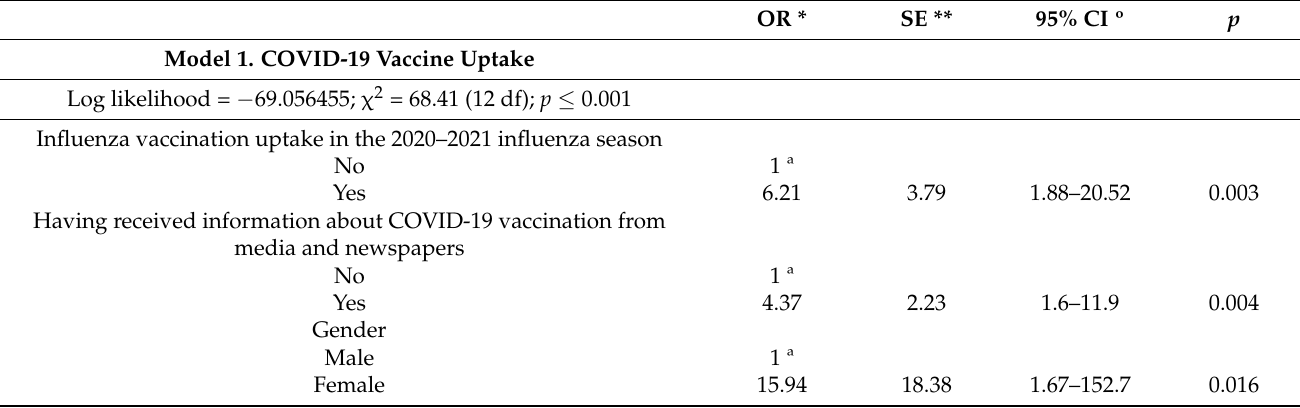
Table 3. Multivariate logistic regression analysis to characterize factors associated with COVID-19 vaccine